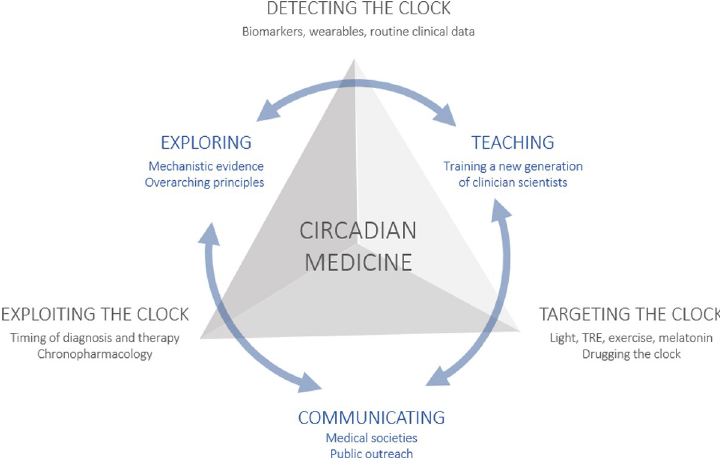
Fig 2. The future of circadian medicine. Our vision for the future of circadian medicine is to firmly integrate it into medical guidelines so that, for each patient, the circadian aspect is always taken into consideration and incorporated into the treatment plan as appropriate. Circadian medicine has many facets and to sustain its development, they all need to be advanced. They include treatment and diagnosis at the right time of day (exploiting), realigning and strengthening the circadian system (targeting), and diagnosing the patient’s circadian characteristics to develop personalized treatment plans (detecting). To achieve this goal, more evidence, especially on overarching principles of circadian medicine, needs to be gathered. To do this, on the one hand, we need a transdisciplinary approach to research, but we also need to train a new generation of physicians and communicate our findings more to the public and decision makers. TRE, time-restricted